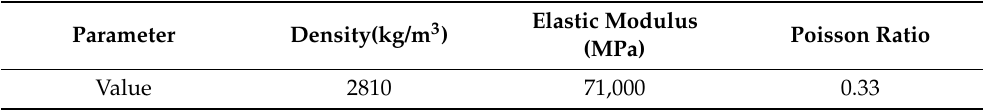
Elastic Modulus Poisson Ratio (MPa)